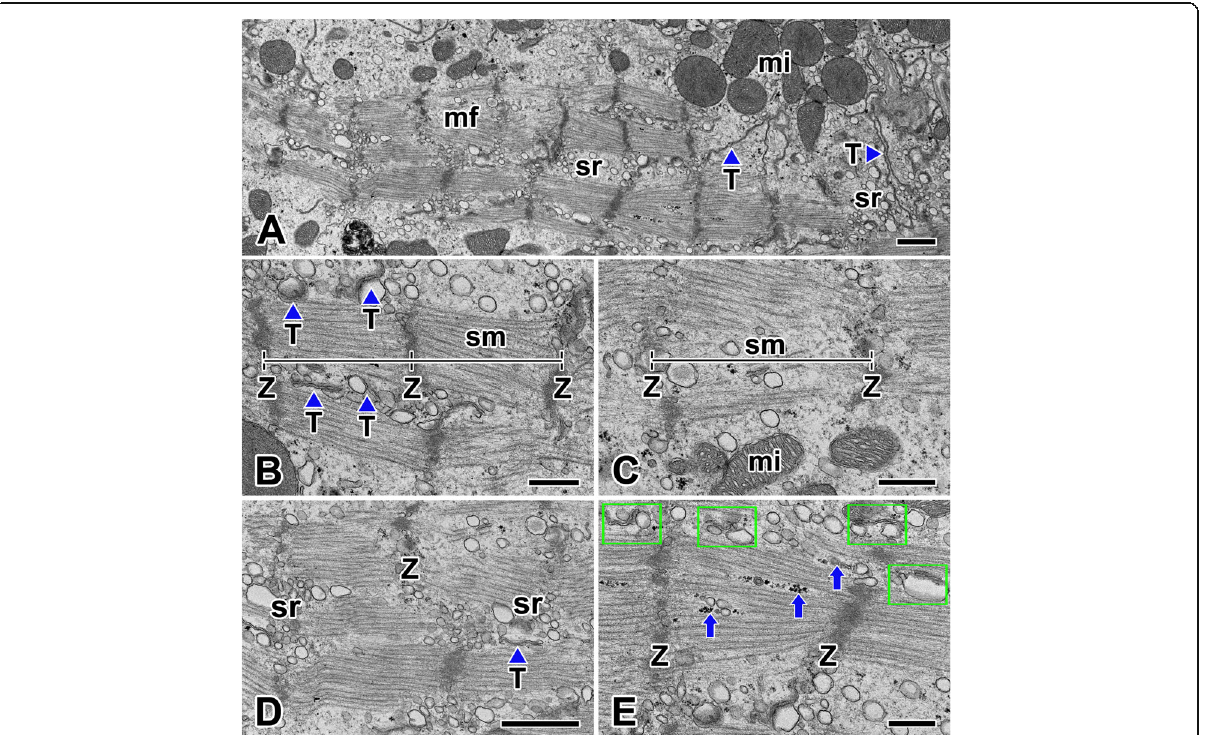
Fig. 4 Electron micrographs of the myofibrils and sarcomere unit of cardiac muscle cells in N. clavata . a : Myofibrils (mf) show repeating units of sarcomere composed of thick and thin myofilaments. b , c : Each sarcomere (sm) is defined by adjacent Z-lines (Z). When muscle contraction occurs, A and I bands are not clear even at high magnification. d , e : Sarcoplasmic reticula (sr) are distributed around the myofibrils, and dyad (rectangles) structures which composed of a single t-tubule (T) and a terminal cisterna of the sarcoplasmic reticulum are seen near the Z-lines. Arrows indicate glycogen particles. mi: mitochondria. Scale bars indicate 1 μ m ( a , b ) and 0.5 μ m ( c-e ),